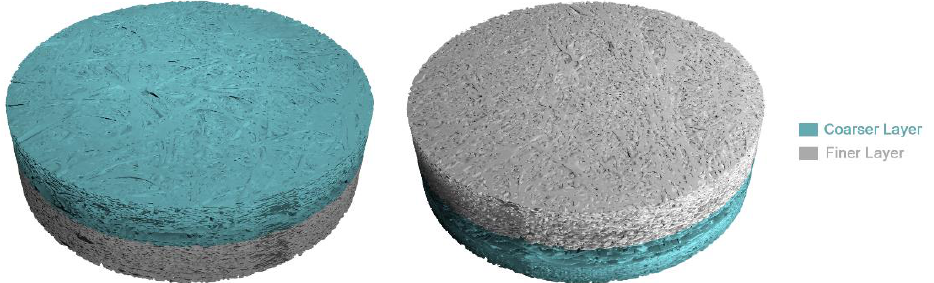
Figure 2. 3D reconstructions from micro-CT images with coarser (light green) and finer layers (light grey).